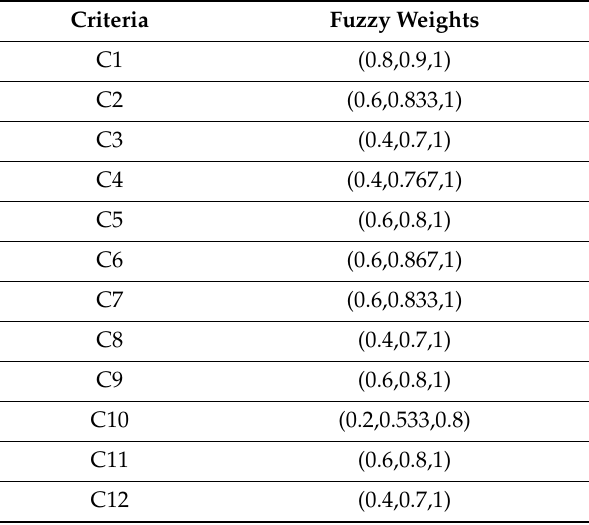
Table 9. Fuzzy aggregated weights of each criterion.